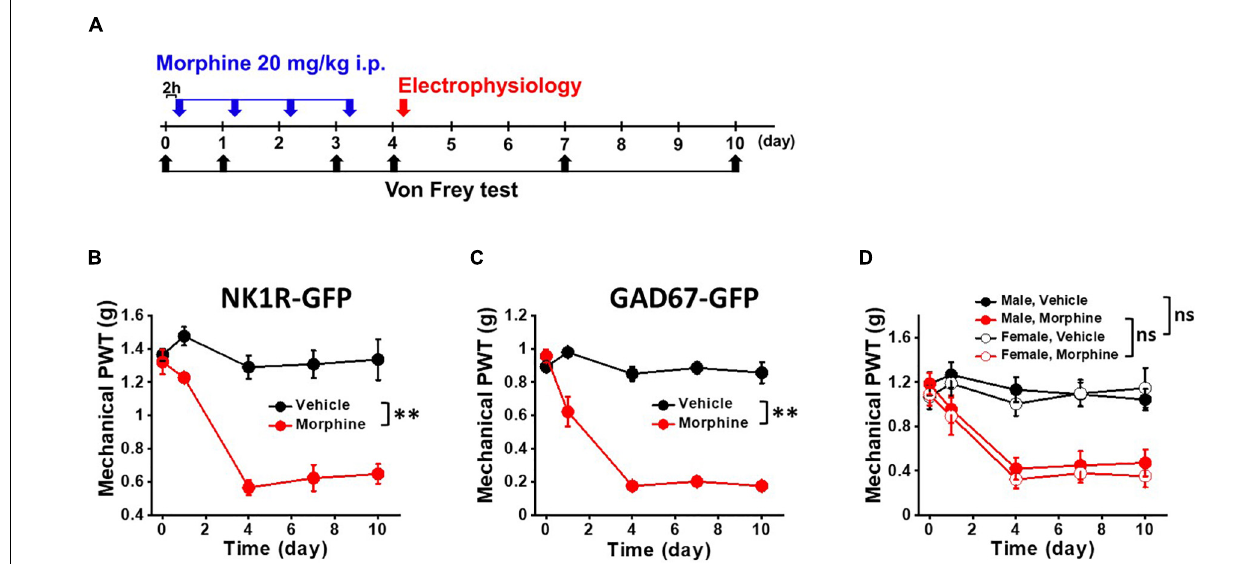
FIGURE 1 | Repeated morphine treatment induced mechanical hypersensitivity in NK1R-GFP and GAD67-GFP transgenic mice. (A) Temporal diagram of drug administration and experiments. Morphine (blue arrow, 20 mg/kg) were administrated by intraperitoneal injection. At day 4, the mice were euthanized for electrophysiological recordings (red arrow). Pain behavioral test was performed 2 h post-morphine injection. Paw withdrawal threshold (PWT) was measured by von Frey tests (black arrow) using (B) NK1R-GFP mice for sNK1Rn ( N = 6 for each group) and (C) GAD67-GFP mice for sGABAn ( N = 6 for each group). (D) No gender effect on the repeated morphine induced mechanical hypersensitivity (Male,Vehicle ( N = 3); Male, Morphine ( N = 3); Female, Vehicle ( N = 3); Female, Morphine ( N = 3). ns: not significant, ∗∗ p < 0.01 vs. vehicle by Sidak’s multiple comparison test following multilevel analysis.